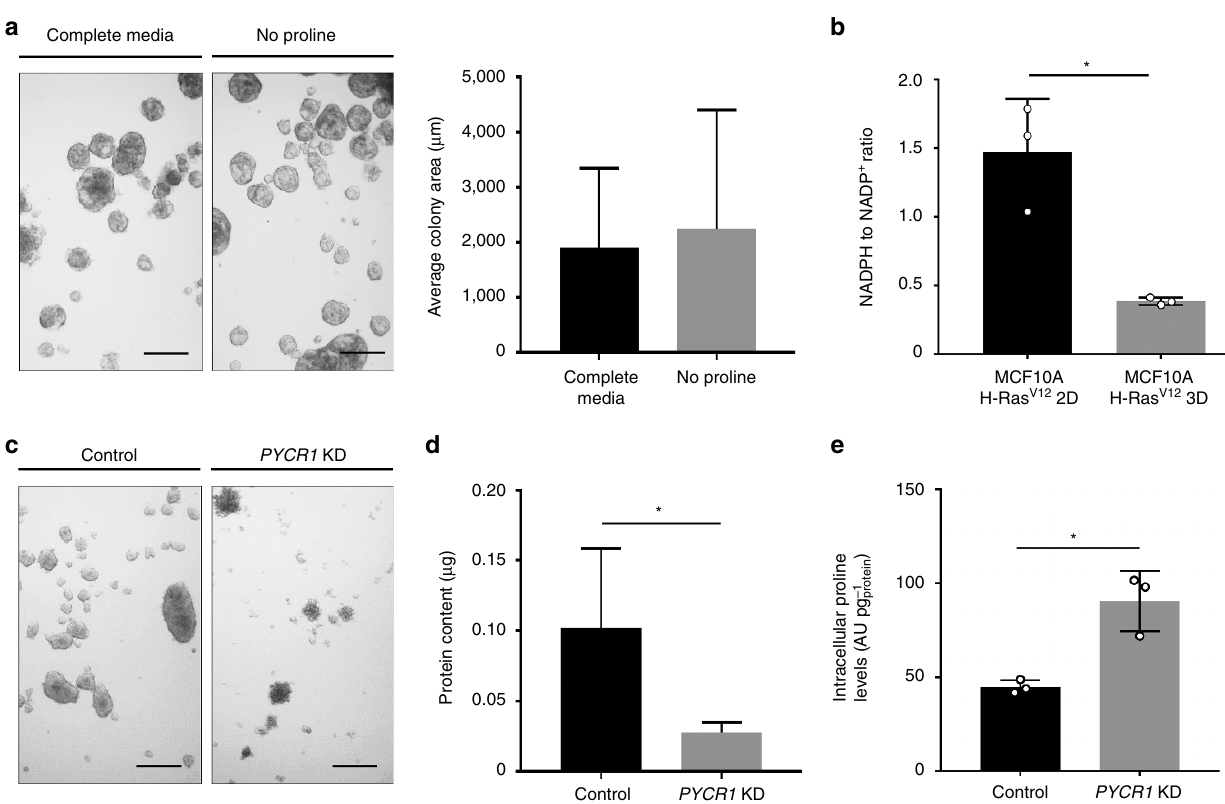
Figure 3 | Prodh activity depends on P5C recycling via Pycr1. ( a ) Representative pictures and size quantification of MCF10A H-Ras V12 spheroids in complete media and media without proline. Analysis was performed at day 5. Scale bar: 150 m m. ( b ) NADPH to NADP þ ratio in MCF10A H-Ras V12 spheroids (3D) versus attached (2D) cells. ( c ) Representative pictures of MCF10A H-Ras V12 spheroids transduced with a lentiviral vector with shRNA for either PYCR1 or a scrambled sequence. Analysis was performed at day 5. Scale bar: 150 m m. ( d ) Protein content in MCF10A H-Ras V12 spheroids transduced with a lentiviral vector with shRNA for either PYCR1 (KD) or a scrambled sequence. Analysis was performed at day 5. ( e ) Intracellular levels of proline in MCF10A H-Ras V12 spheroids transduced with a lentiviral vector with shRNA for either PYCR1 (KD) or scrambled sequence. Analysis was performed at day 5. Total ion counts were normalized for protein content. The number of biological replicates for each experiment was n Z 3. All error bars represent s.d. Two-tailed unpaired Student’s T -test was performed. * P r